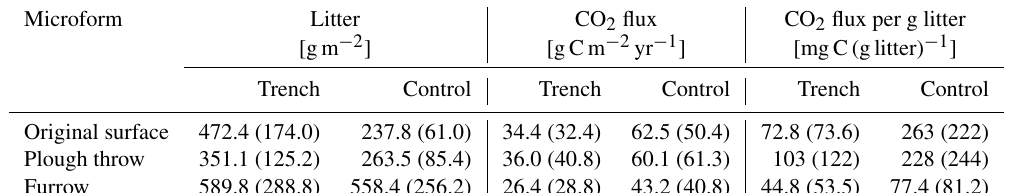
Table 3. Mean amount of C emitted as CO 2 by surface needle litter in litter collars, for both years (standard error in brackets).